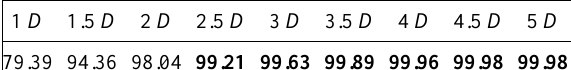
Table 1 . Average results for nine tree sets. (The best values are bold, and D refers to the average